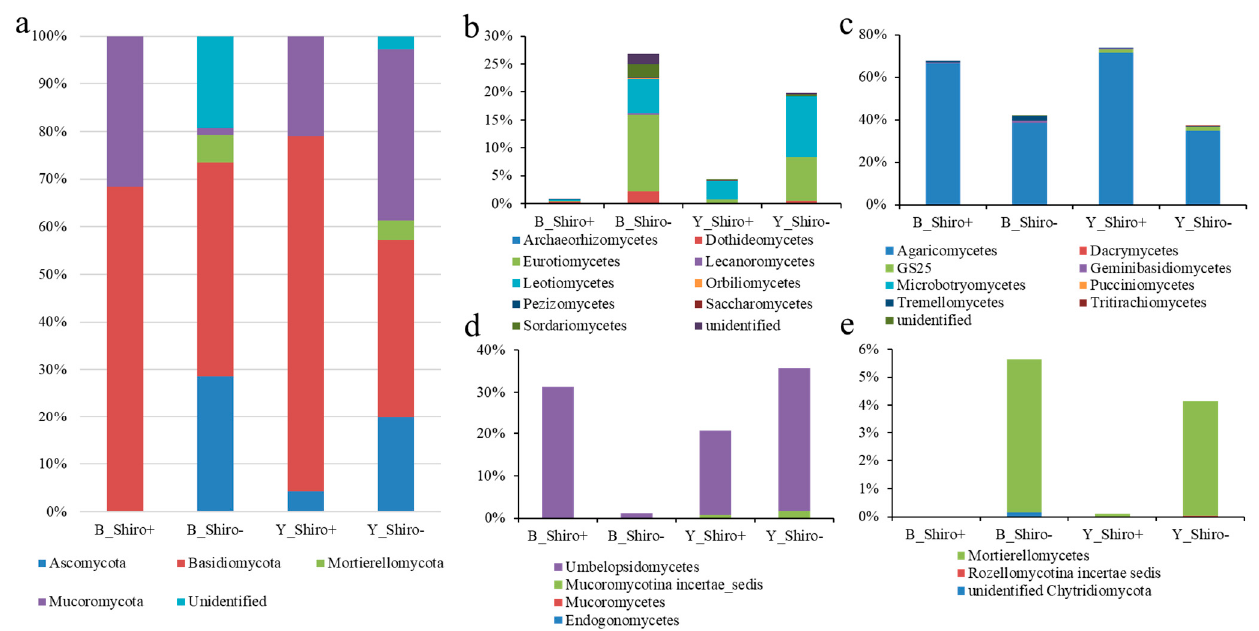
Figure 4. Taxonomic composition analysis of fungal communities at phylum level ( a ) and class level ( b – e ) inhibiting the Tricholoma matsutake production (shiro+) and nonproduction (shiro − ) soils of Bonghwa and Yangyang sampling sites. ( b ) ten fungal classes of Ascomycota phylum, ( c ) 8 fungal classes of Basidiomycota phylum, ( d ) 4 fungal classes of Mucoromycota phylum, and ( e ) fungal classes from the phyla Chytridiomycota, Rozellomycota, and Mortierellomycota.